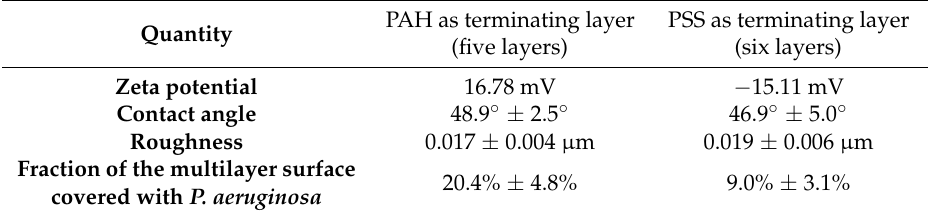
Table 1. Characterisation of PAH/PSS polyelectrolyte multilayers with PAH or PSS as the terminating layer in terms of terminating layer charge (i.e., zeta potential), contact angle value, roughness, and finally the fraction of the corresponding multilayer covered with